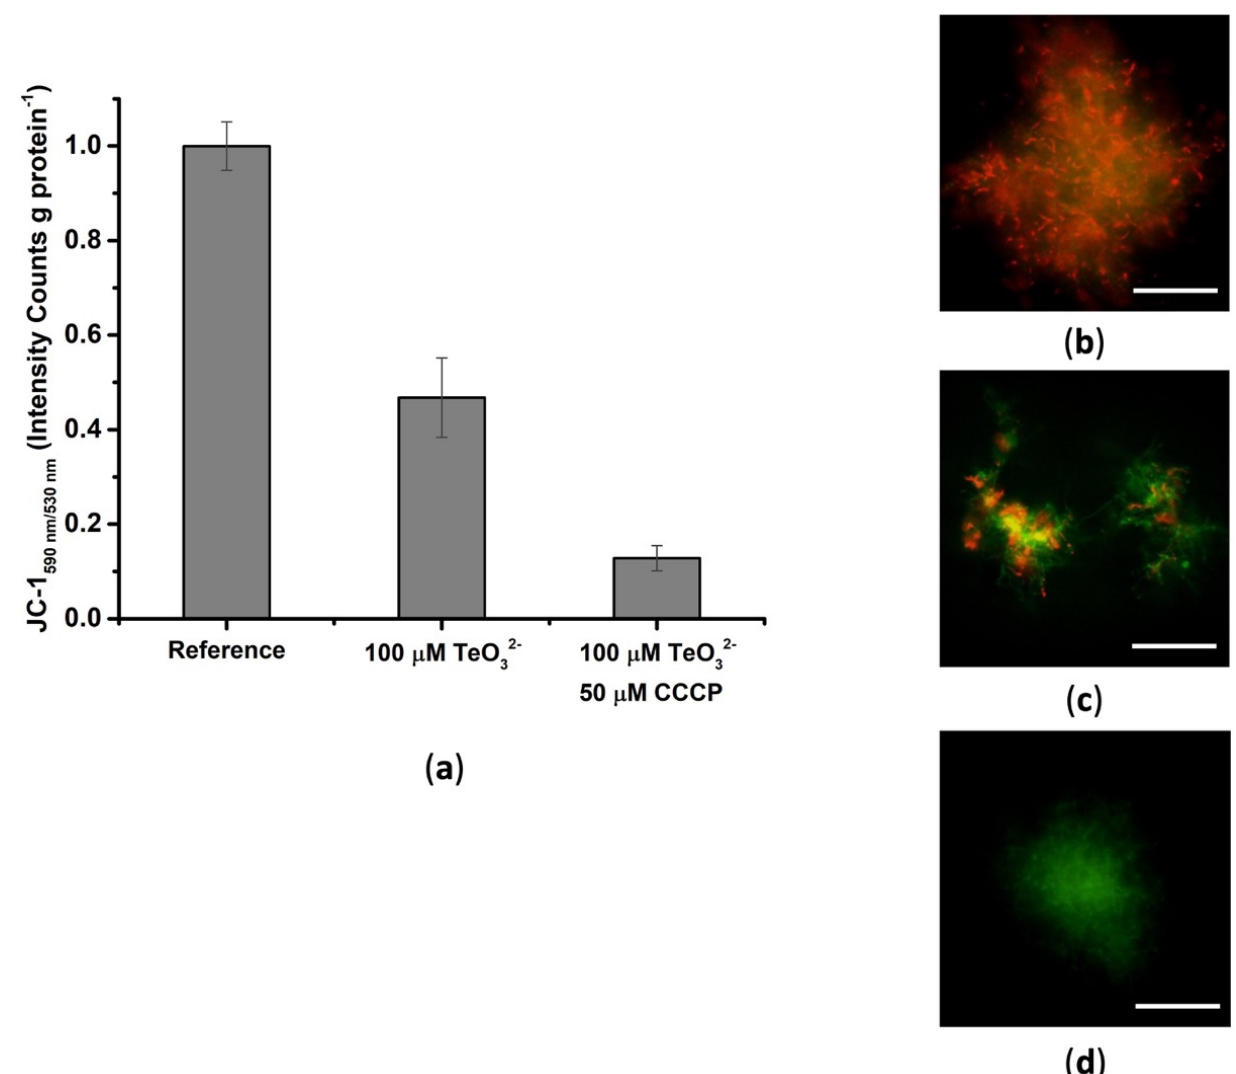
Figure 2. Effect of tellurite on the membrane potential of Micromonospora exponentially grown cells, evaluating the 590/530 JC-1 fluorescence emission ratios ( a ) and fluorescence imaging of ( b ) unchallenged cells or those exposed to ( c ) 100 µ M TeO 32 − and ( d ) 50 µ M CCCP. Scale bar 50 µ m. In line with growth profiles, a cell viability assay (Section 4.4), carried out through Table 1. The relative percentage of total fatty acids isolated from Micromonospora cells exposed for fluorescence microscopy, revealed a strong green-fluorescent signal only in the case of 6-h to TeO 32 − . Micromonospora unchallenged cells at its RG1 phase (Figure 4a). On the contrary, the lag phase determined by the TeO 32 − challenge led to the detection of a mixed population of viable and non-viable cells, as indicated by the simultaneous green, red, and yellow fluorescence emission (Figure 4b,c). This evidence suggests that propidium iodide (red dye) can penetrate cells featuring damage to their cell